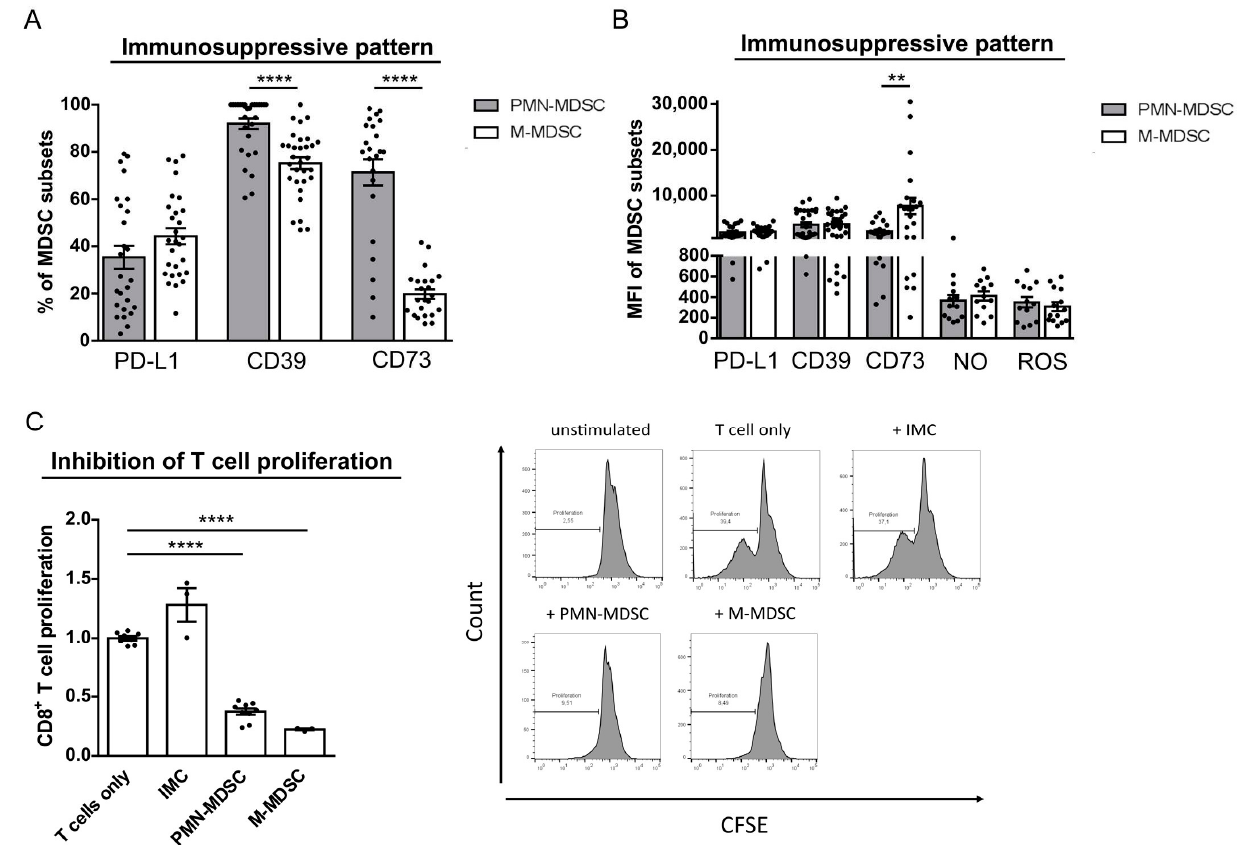
Figure 2. Immunosuppressive activity of MDSC subsets in melanoma bearing RET transgenic mice. ( A , B ) The expression of PD-L1, CD39 and CD73 as well as the production of NO and ROS was measured in PMN- and M-MDSC isolated from skin tumors of RET transgenic mice. The results are presented as the percentage of PD-L1 + , CD39 + or CD73 + cells within respective MDSC subpopulations (( A ), mean ± SEM; n = 13–29 mice/group) or the level of their expression as well as of the NO and ROS production measured as mean fluorescence intensity (MFI) ( B ) For staining of CD73 and PD-L1 isotype controls were used while CD39, NO, and ROS expression was determined using up to fluorescence minus four (FM4) controls. ( C ) Inhibition of CD8 + T cell proliferation by PMN- or M-MDSCs and representative histograms for the corresponding FACS stainings. T cells stimulated with anti-CD3 and anti-CD28 antibodies were cultured for 96 h alone or together with CD11b + Gr1 + immature myeloid cells (IMC) from the BM of healthy mice or with tumor PMN- or M-MDSC from skin melanoma at the T cell:MDSC ratio 1:2. Proliferation was analyzed by flow cytometry. Data are normalized to the T cells only control (mean ± SEM; n = 3–9 mice/group). ** p < 0.01, **** p < 0.0001.